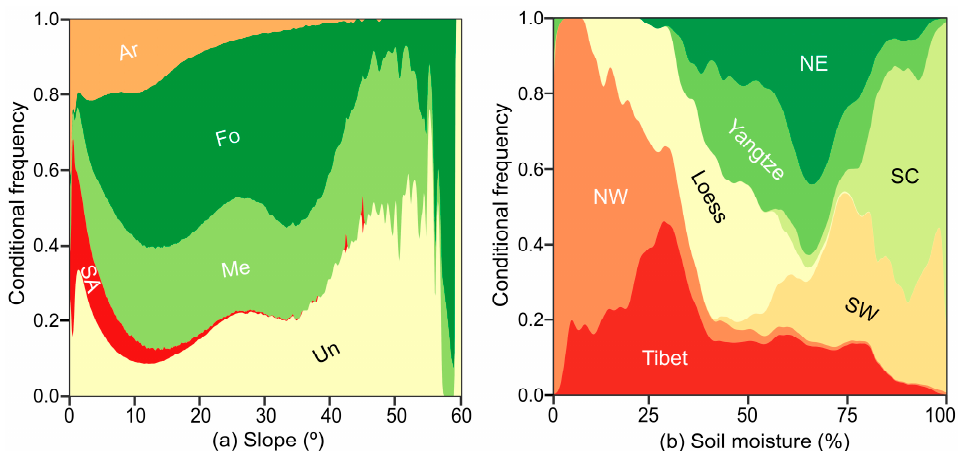
Figure 6. Conditional frequency plots between ( a ) land use and slope; ( b ) geological environment division and soil moisture.